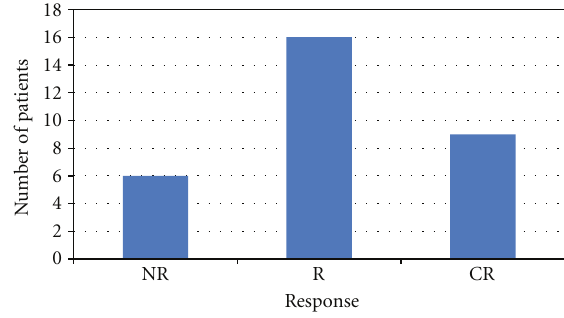
Figure 2: Maximum platelet